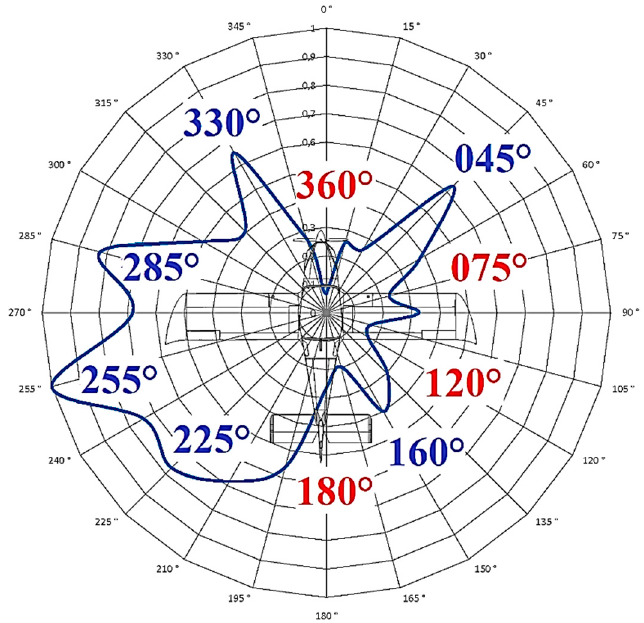
Figure 15. Basic shape of the characteristic at an angle θ of 2° with maximum and minimum radiation marked.